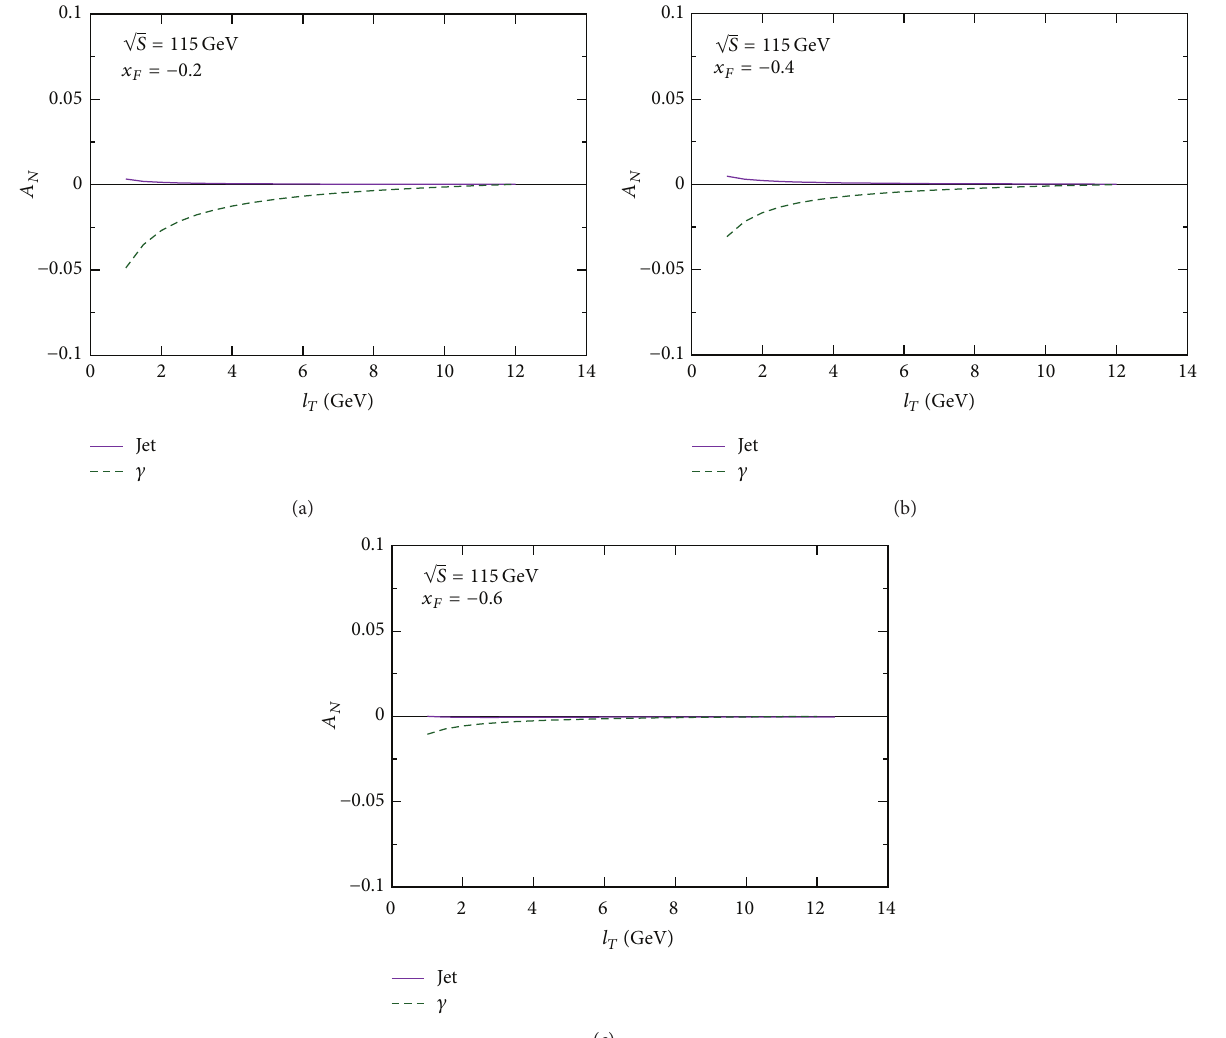
Figure 4: 𝐴 𝑁 versus 𝑙 𝑇 at fixed 𝑥 𝐹 = −0.2 (a), 𝑥 𝐹 = −0.4 (b), and 𝑥 𝐹 = −0.6 (c) at √𝑆 = 115 GeV for jet/photon production at